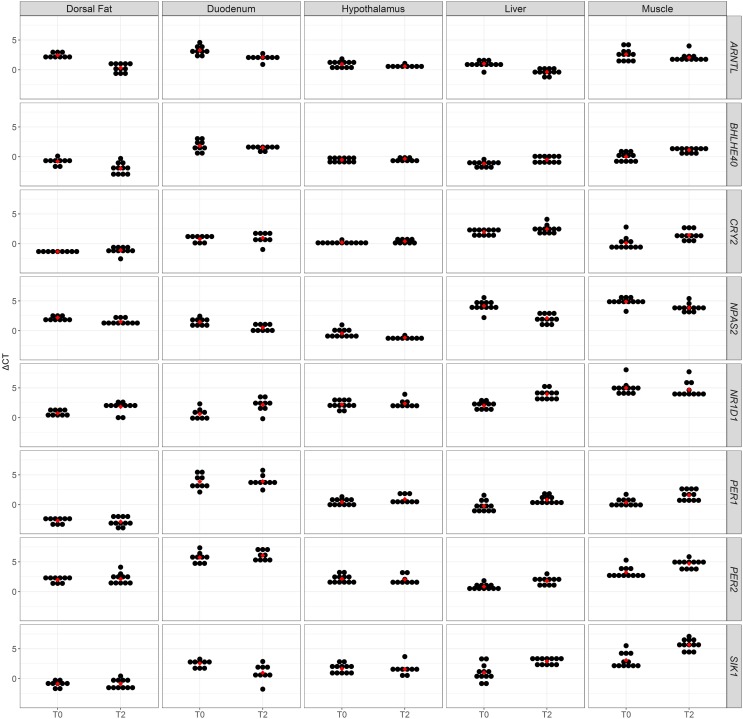
A dot plot of ΔCT values of eight clock genes obtained in five tissues from fasting (T0) and fed (T2) sows. Average ΔCT values are represented as red dots.